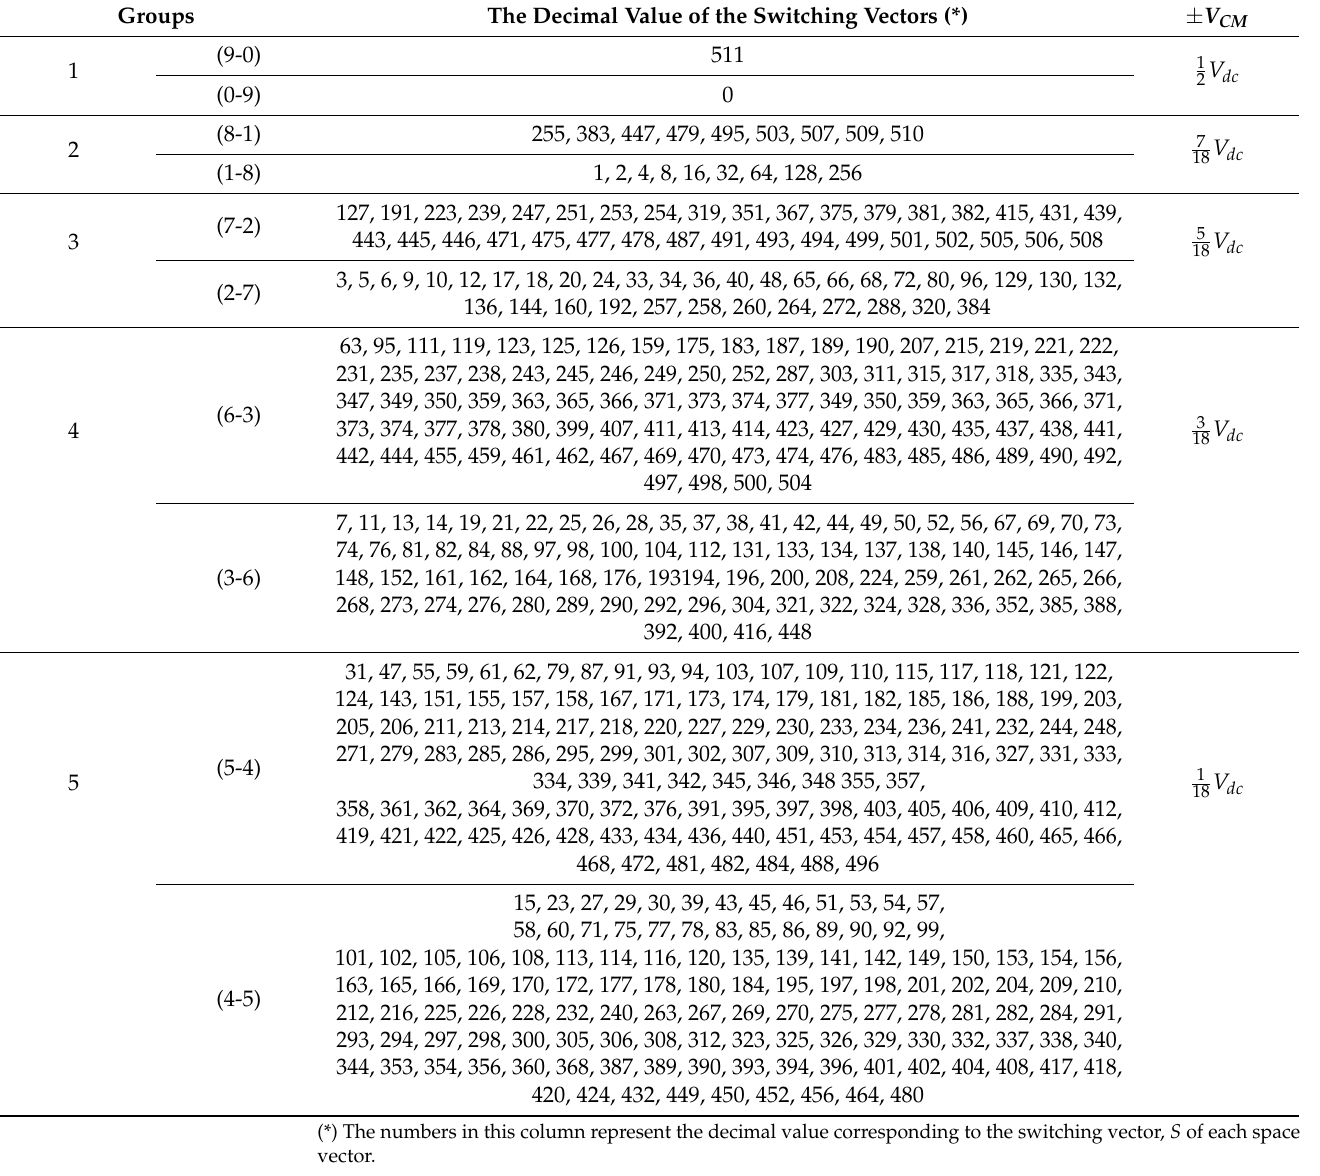
Table 2. Switching table for nine-phase VSI and corresponding CMV.